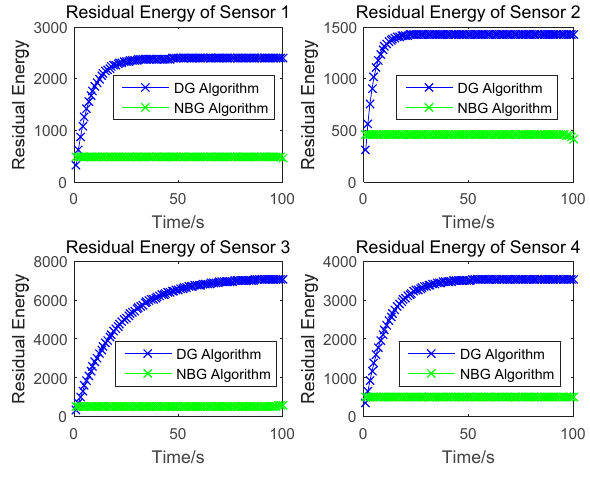
Figure 9. Residual energy of sensors.